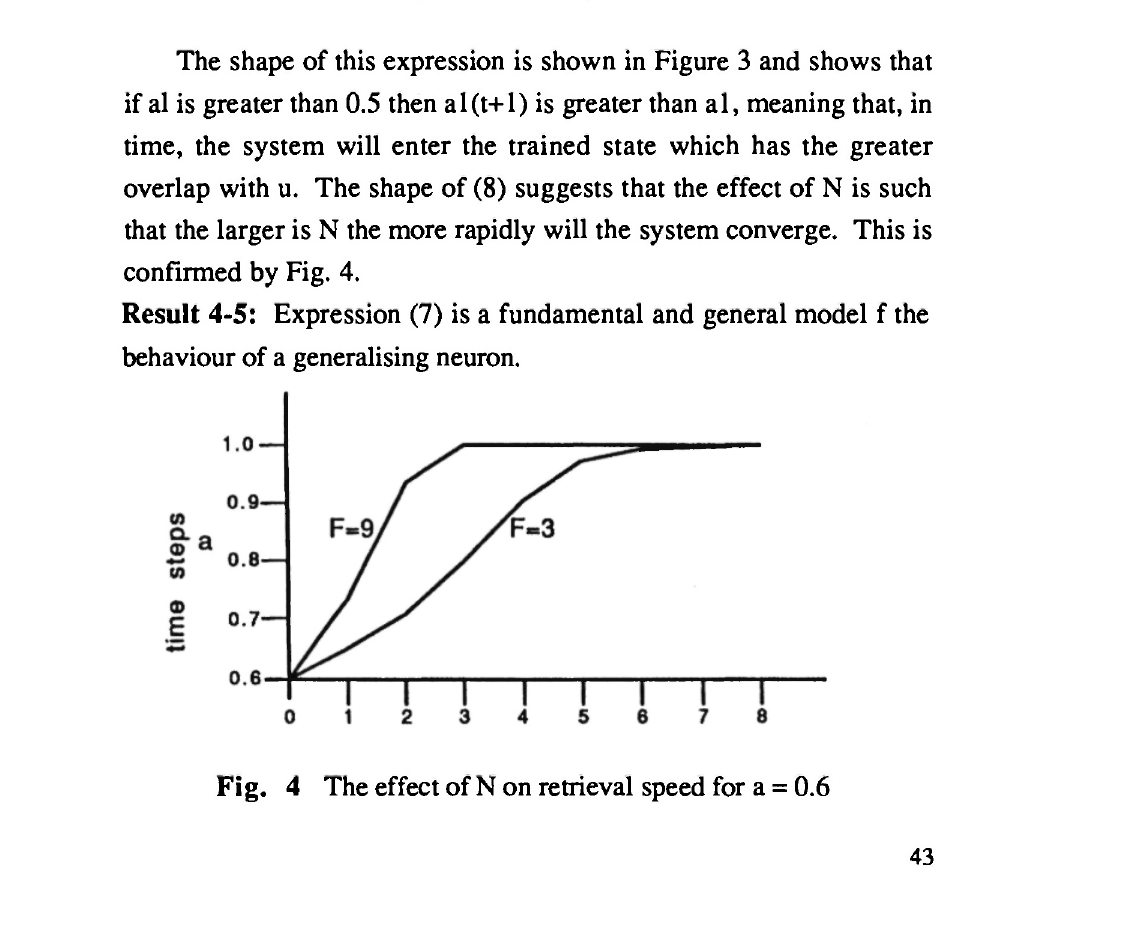
Fig. 3 The shape of (8)